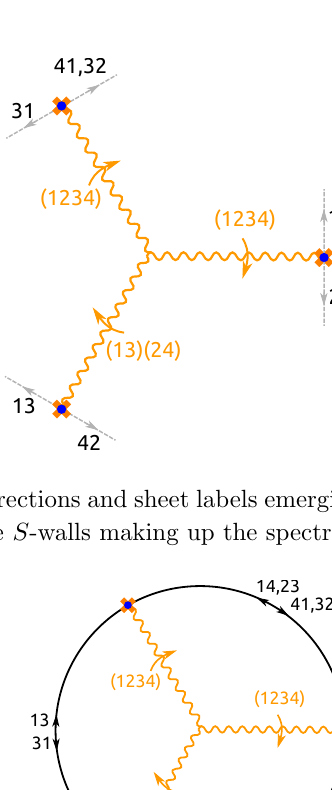
Figure 3 . The spectral network of the theory at the phase # = 5 (cid:25) computing BPS states with charge n(cid:13) 1 . All 3 arcs shown support \double walls", i.e. superpositions of a wall of type ij and a wall of type ji , with opposite orientations. The arc at the northeast is even more degenerate: it is a superposition of two double walls, one of type 14 = 41 and one of type 23 = 32. exactly degenerate: e.g. emanating from the puncture at z = z 14 which is exactly degenerate with a wall labeled